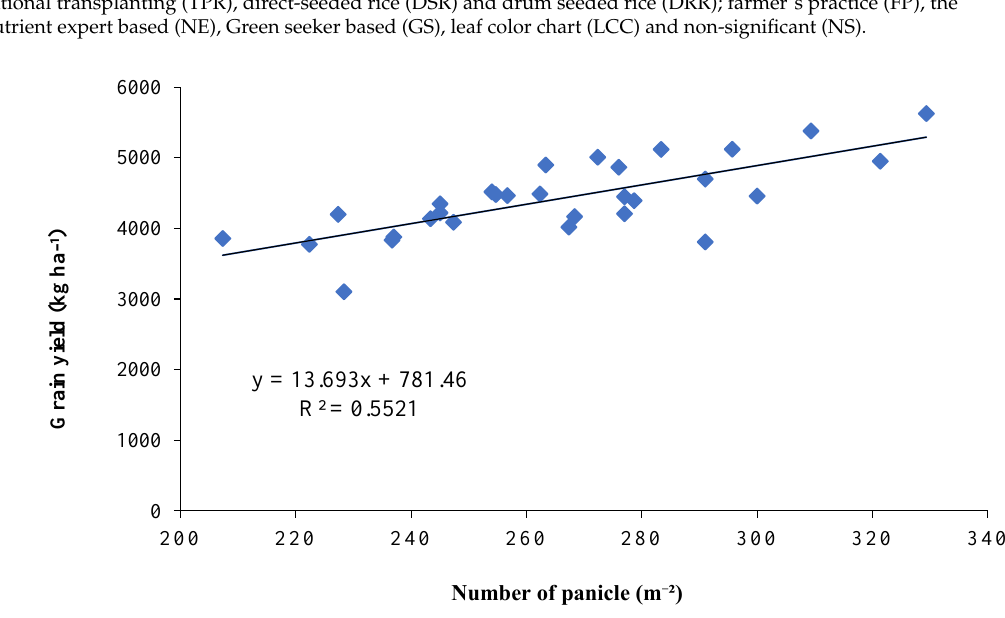
Figure 2. Linear regression between yield (kg ha − 1 ) and panicles (m − 2 ) of “Pratikhya” Kharif rice va- riety.